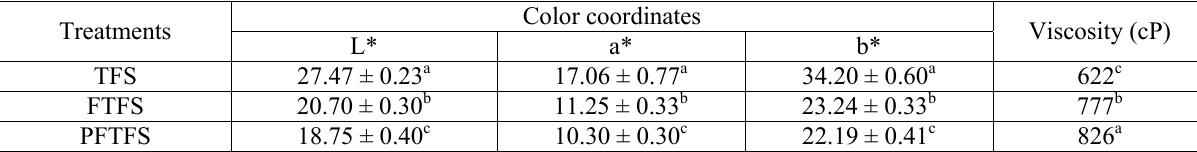
Table 5. Physical characteristics of fortified Vietnamese tamarind fish sauce before and after pasteurization